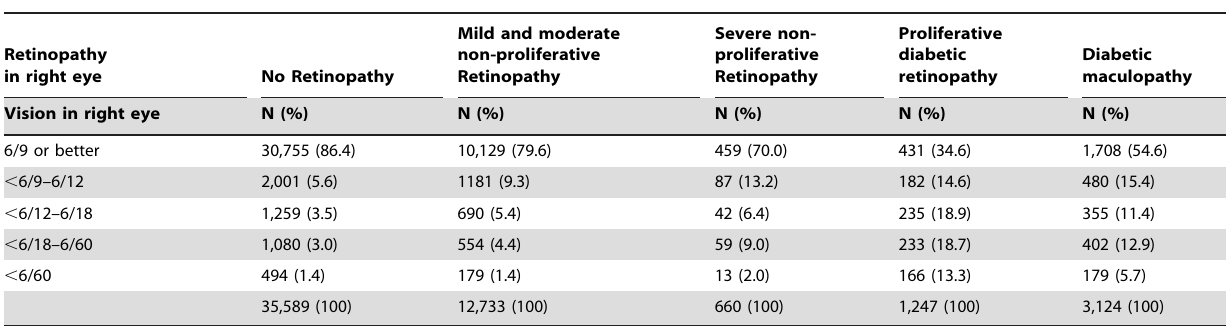
Table 6. Vision and diabetic retinopathy.